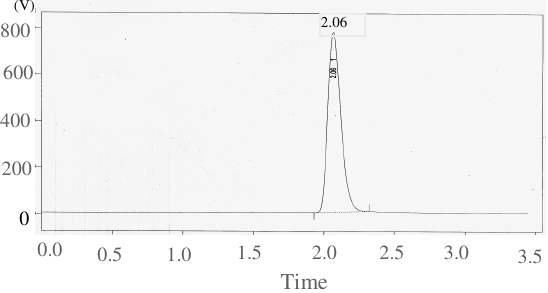
Figure 1. Typical chromatogram of standard atenolol